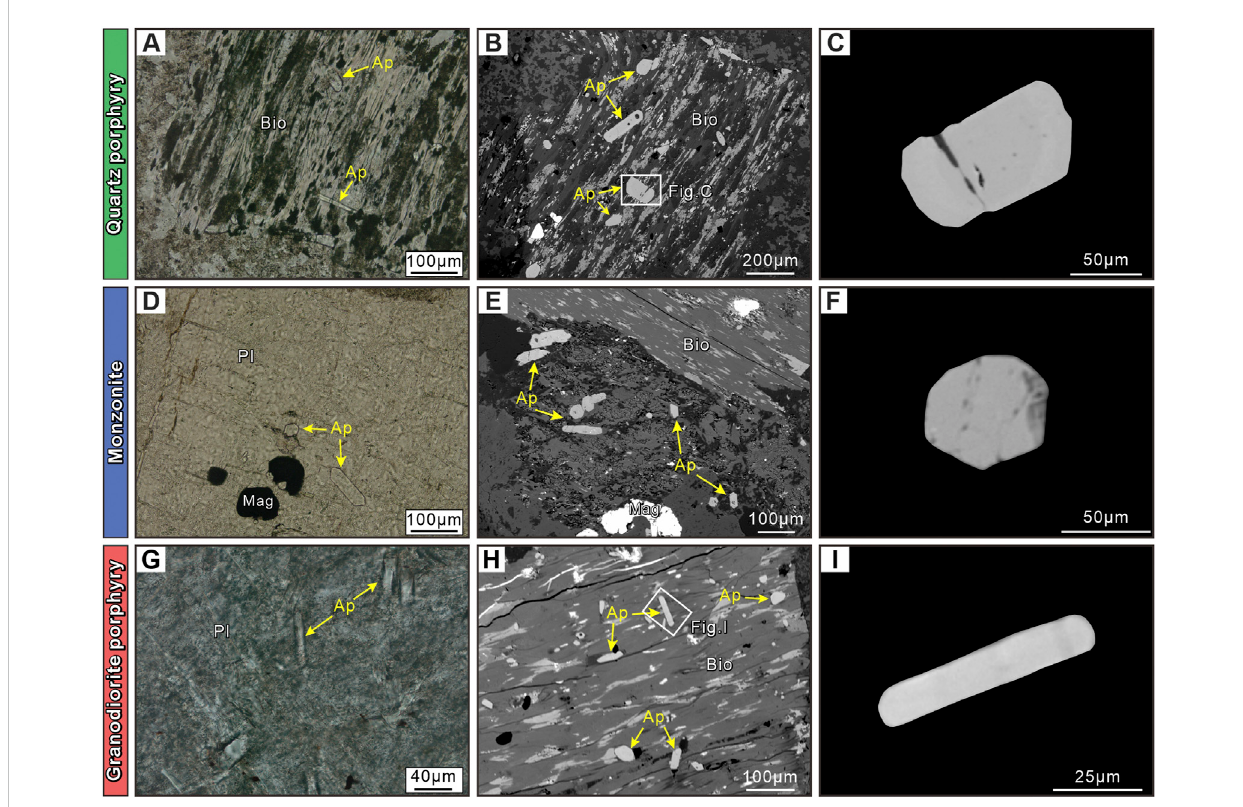
FIGURE 4 Plane-polarized photomicrographs (A, D, G) and BSE images (B, C, E, F, H, I) illustrating petrographic features of representative apatite from the Kalmakyr porphyry deposit. (A) Euhedral to subhedral, elongated and columnar magmatic apatite occurs as inclusions in quartz porphyry ’ s biotite; (B) Euhedral to subhedral, homogeneous magmatic apatite occurs as inclusions in quartz porphyry ’ s biotite; (C) Unaltered magmatic apatite, displaying a weak core – rim texture and the homogeneous surface of quartz porphyry; (D) Euhedral to subhedral, prismatic and granular magmatic apatite occursasinclusionsintheplagioclasephenocrystofmonzonite; (E) Euhedraltosubhedralmagmaticapatitewithminormineralinclusionsofmonzonite; (F) Granularmagmaticapatite of monzonite; (G) Euhedral to subhedral, columnar magmatic apatite occurs asinclusionsin theplagioclasephenocrystof granodiorite porphyry; (H) Euhedral to subhedral, columnar and granular magmatic apatite occurs as inclusions in the biotite phenocryst of granodiorite porphyry; and (I) Columnar magmatic apatite with a homogeneous surface of granodiorite porphyry. Mineral abbreviations: Ap, apatite; Bio, biotite; Pl, plagioclase; Mag,